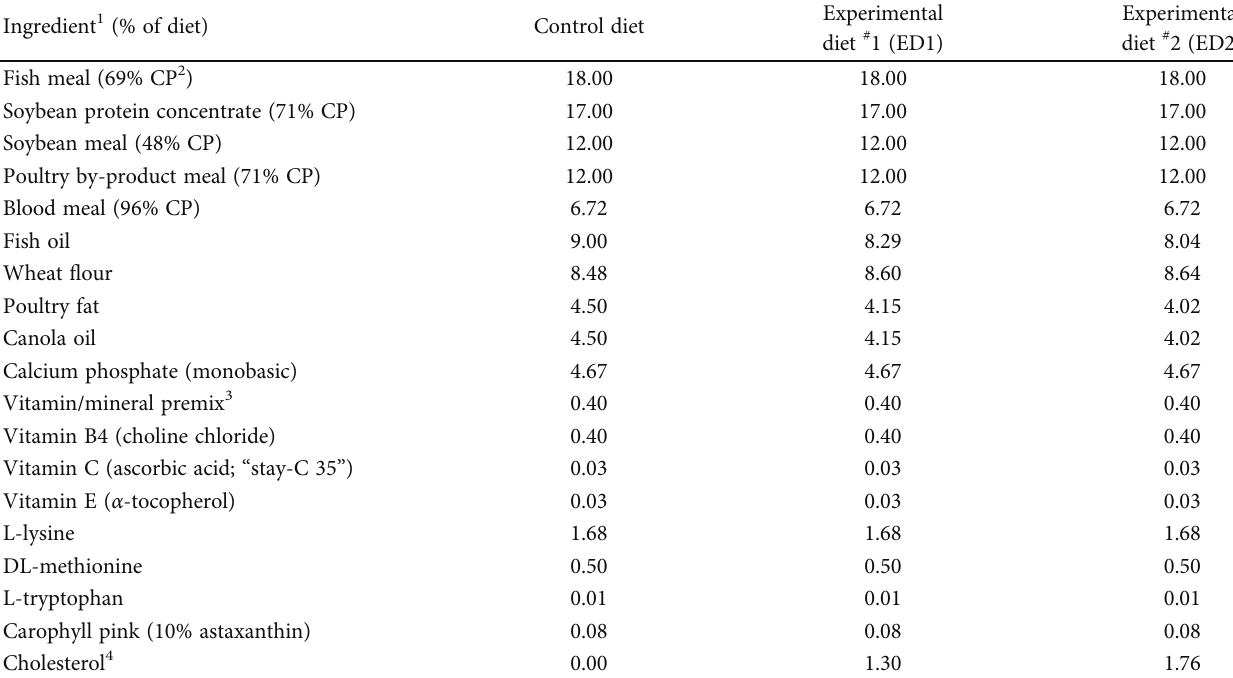
Table 1: Formulation of the test diets used to evaluate the e ff ect(s) of supplemental dietary cholesterol on female triploid Atlantic salmon exposed to elevated